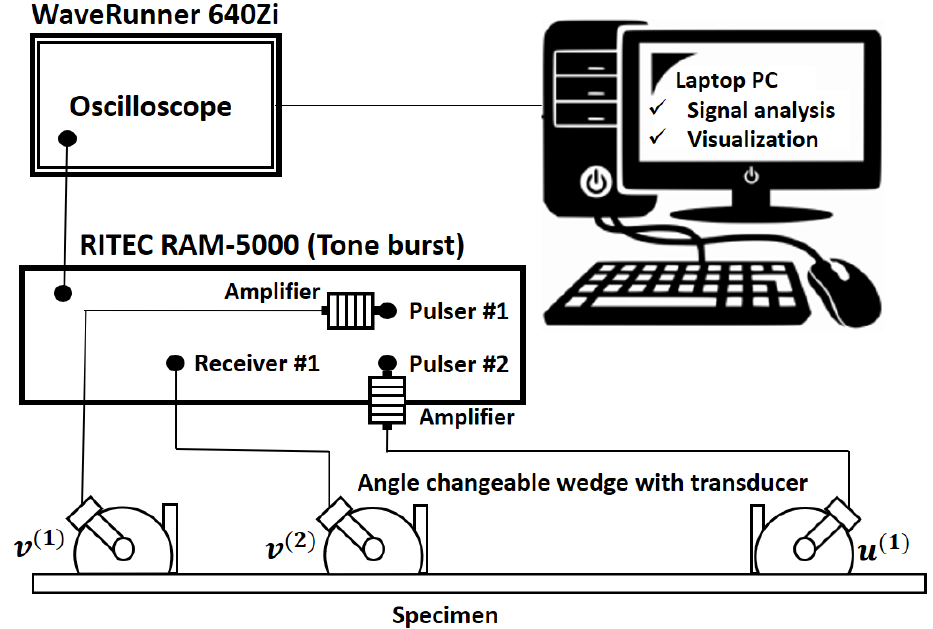
Figure 7. Experimental setup for material evaluation by guided wave mixing. The mixing signal propagation direction was calculated for the two possible